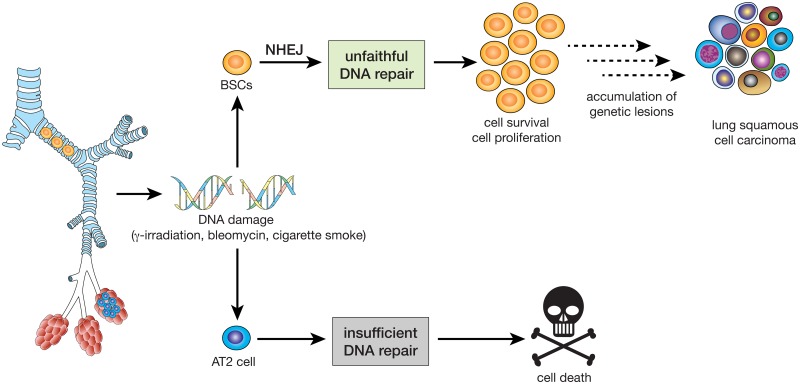
Lung BSCs have a rapid yet error-prone response to DNA damage through nonhomologous end joining (NHEJ).This allows the cells to continue to survive and proliferate after DNA injury and may eventually result in the accumulation of genetic lesions that lead to SqCC formation. In contrast, AT2 progenitor cells have an insufficient response to DNA damage, resulting in cell death.